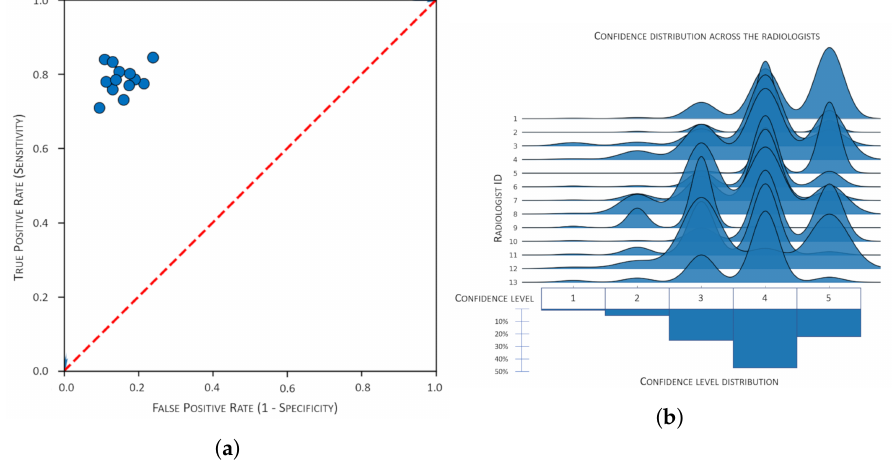
Figure 7. Results in graphical form. ( a ) The raters’ performance in the ROC space: Circles represent single raters. The red line represents random guessing. ( b ) Joyplot and histogram illustrating the raters’ confidence